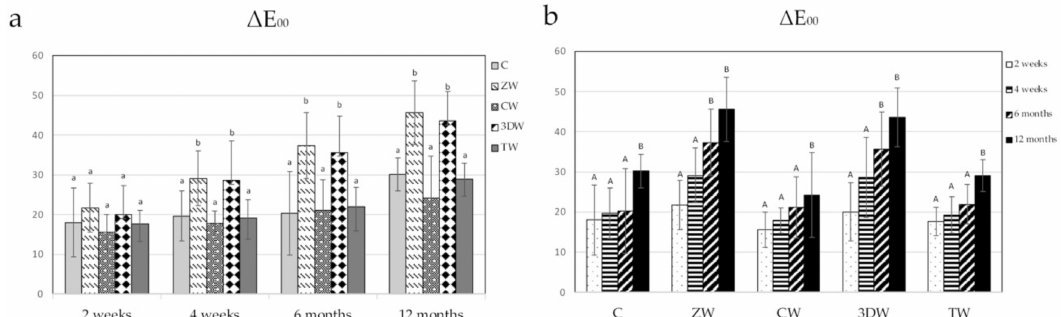
Figure 5. ( a ) ∆ E 00 after brushing at each time point analysed using one-way ANOVA and LSD post hoc test. Different lowercase letters indicate statistically significant differences among toothpaste groups ( p < 0.05). ( b ) ∆ E 00 after brushing among time points analysed using Friedman test with Dunn’s post hoc test. Different capital letters indicate statistically significant differences only among the evaluation periods in the same groups ( p <